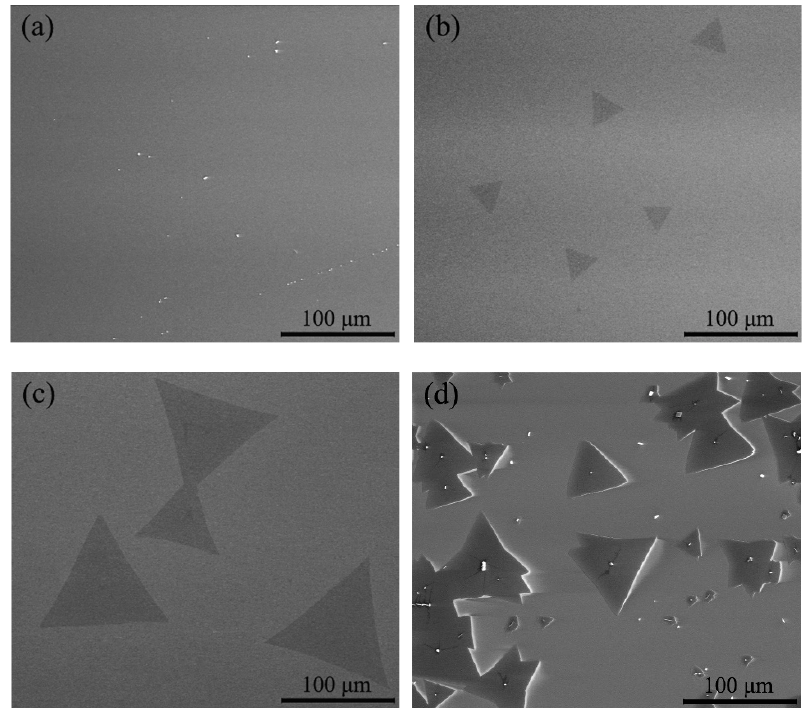
Figure 5. SEM images of MoS 2 prepared from different temperatures: ( a ) 1048 K, ( b ) 1073 K, ( c ) 1098 K, ( d ) 1123 K.